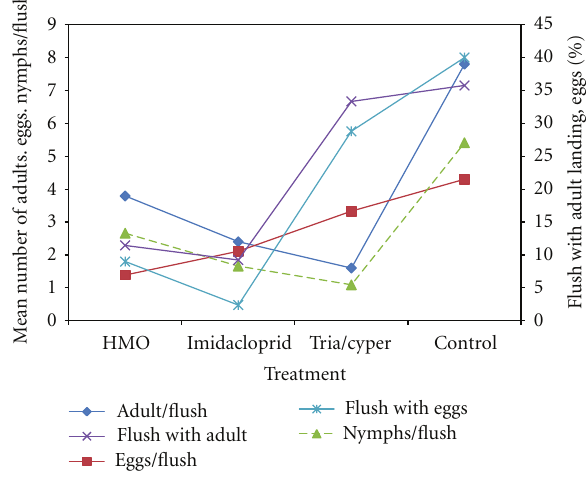
Figure 3: E ff ects of treatments on D. citri infestations on flush growth during August